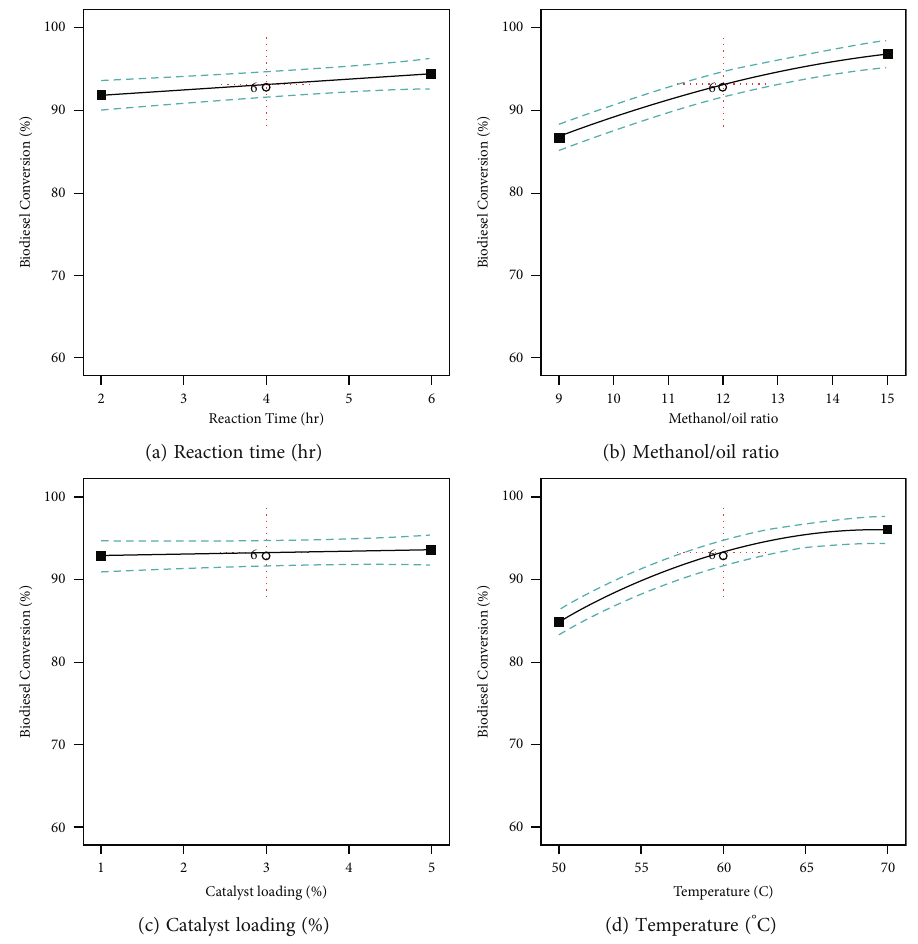
Figure 10: The impact of various process factors on biodiesel yield or